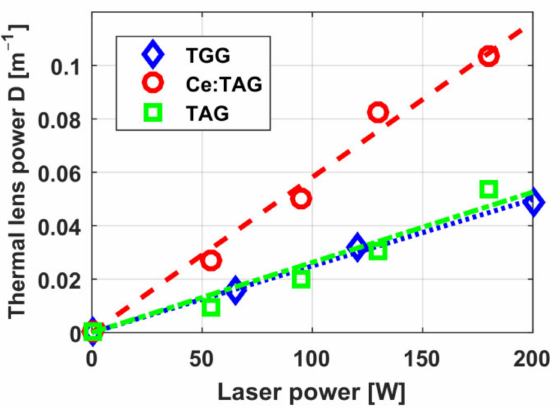
Figure 2. The optical power of thermal lens D as a function of laser radiation power in TGG and TAG-based FIs,